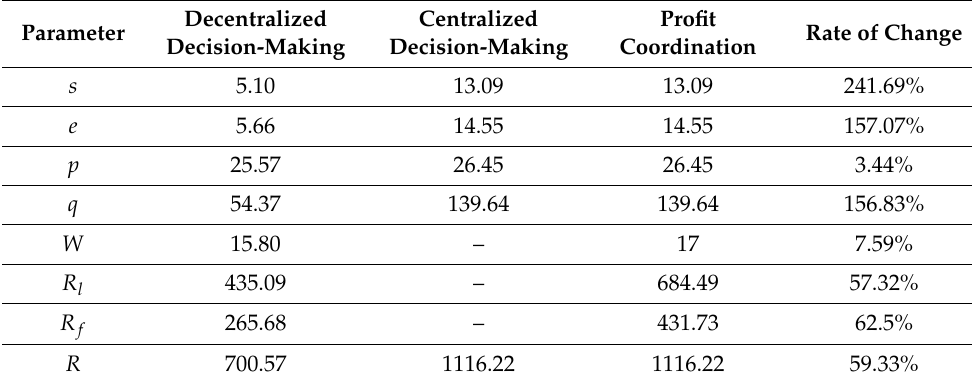
Table 9. Contract coordination results of the E-commerce platform and farmer